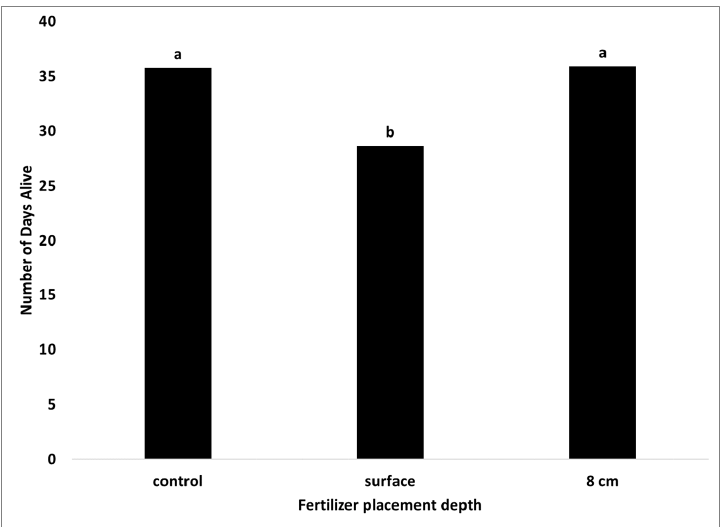
Figure 13. Seedling longevity, number of days alive, as a function of fertilizer placement depth in a glasshouse study with bottlebrush squirreltail and Siberian wheatgrass. Data were averaged across species and SAP rates of 0 and 3000 kg ha − 1 applied in a band at a depth of 8 cm directly below the seed. Following SAP treatment, the soil was saturated once and then dried down naturally over the time of the study. The fertilizer was applied at a depth of 8 cm directly below the seed prior to saturation or at the soil surface at the time of planting. Bars with different letters are statistically different from each other p = 0.0584.